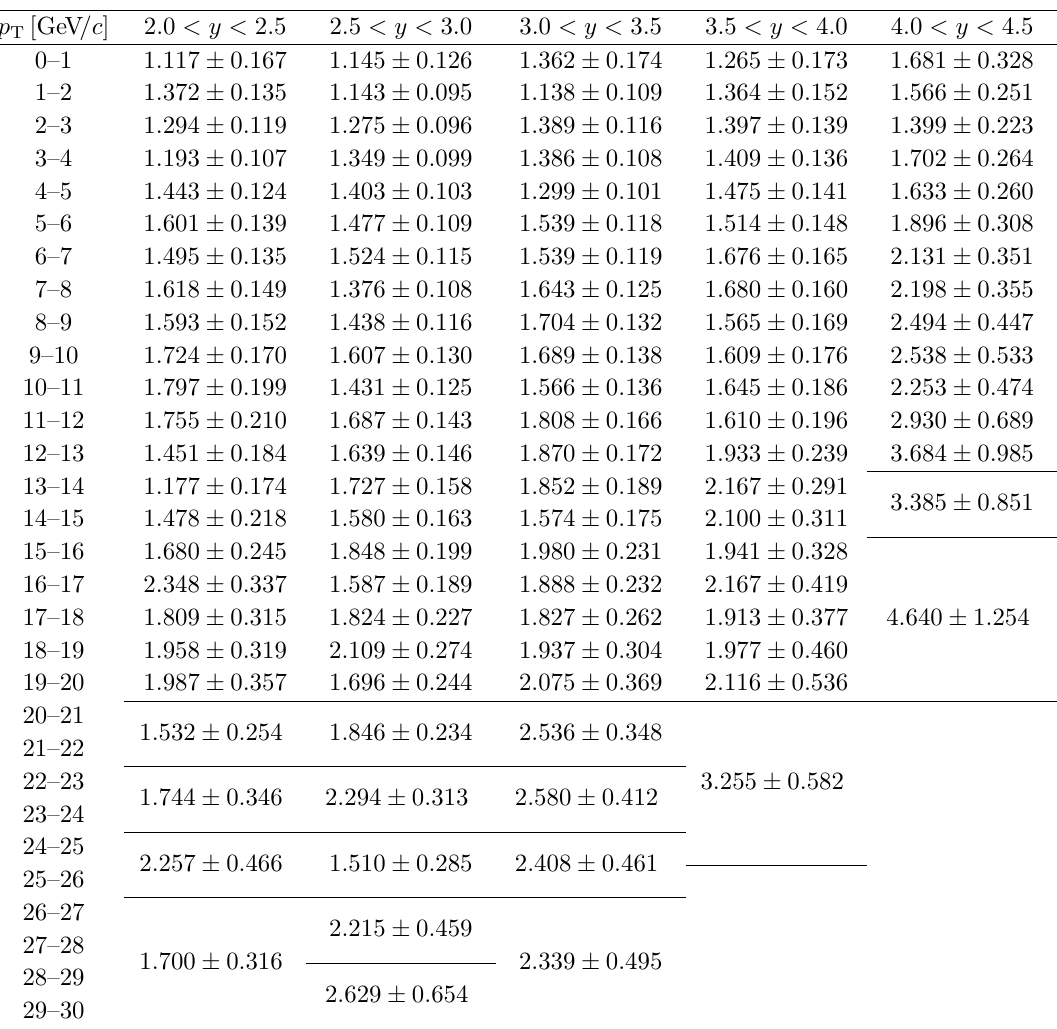
Table 7 . The cross-section ratios between 13 TeV and 8 TeV in di(cid:11)erent bins of p T and y for (cid:7) (3 S